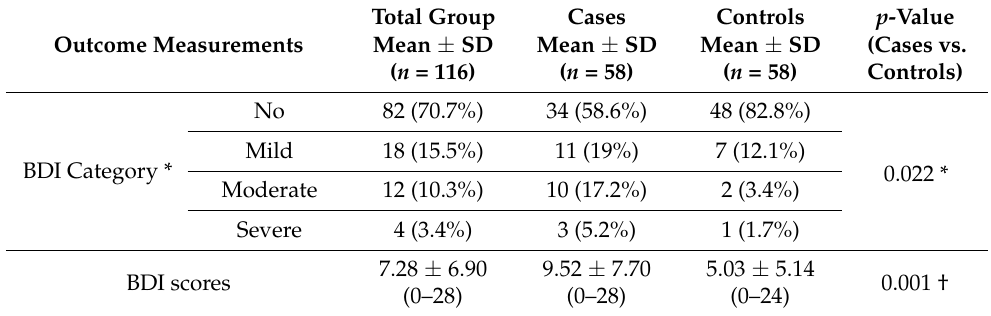
Table 2. Relationship of scores and categories of the BDI between patients with MS and healthy controls.